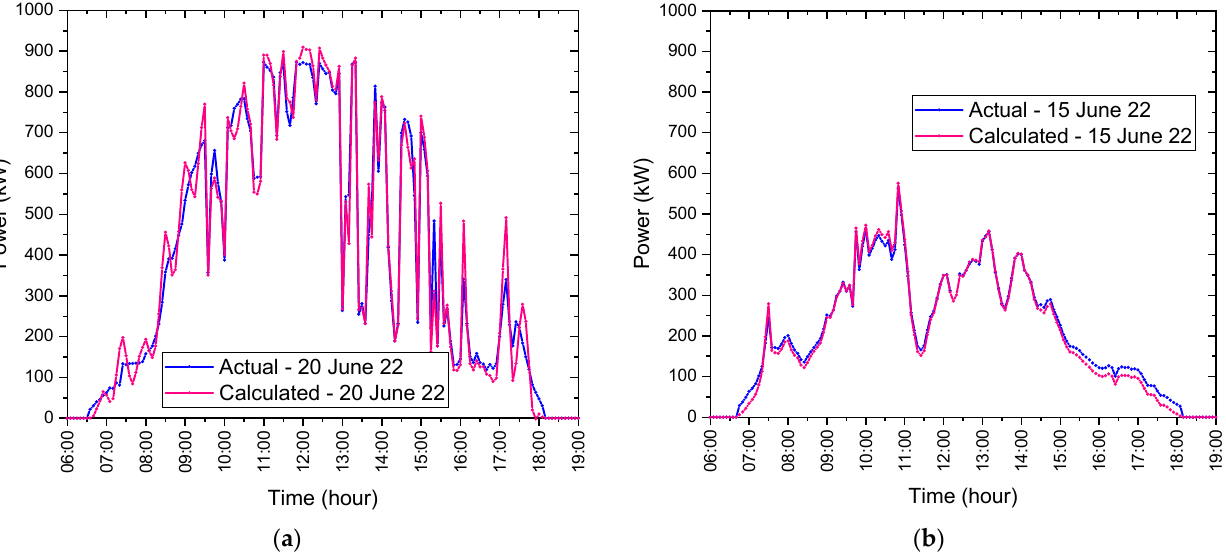
Figure 12. The validation results of the electrical power production from the 0.99 MW solar rooftop site: ( a ) on a sunny day with intermittent cloud in the afternoon—20 June 2022; and ( b ) on a cloudy day—15 June 2022.